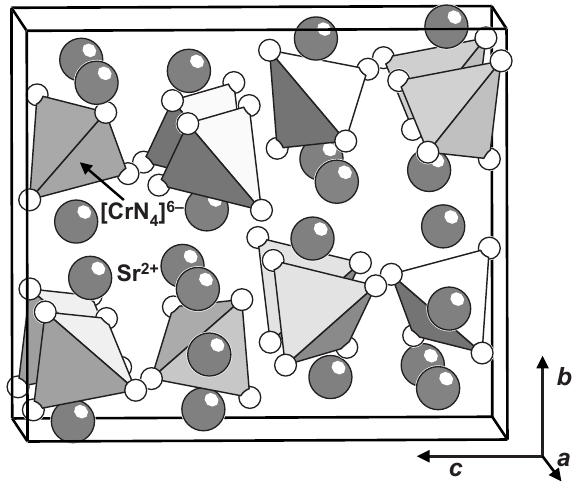
Table 2. Atomic coordinates and displacement parameters (in Å 2 )